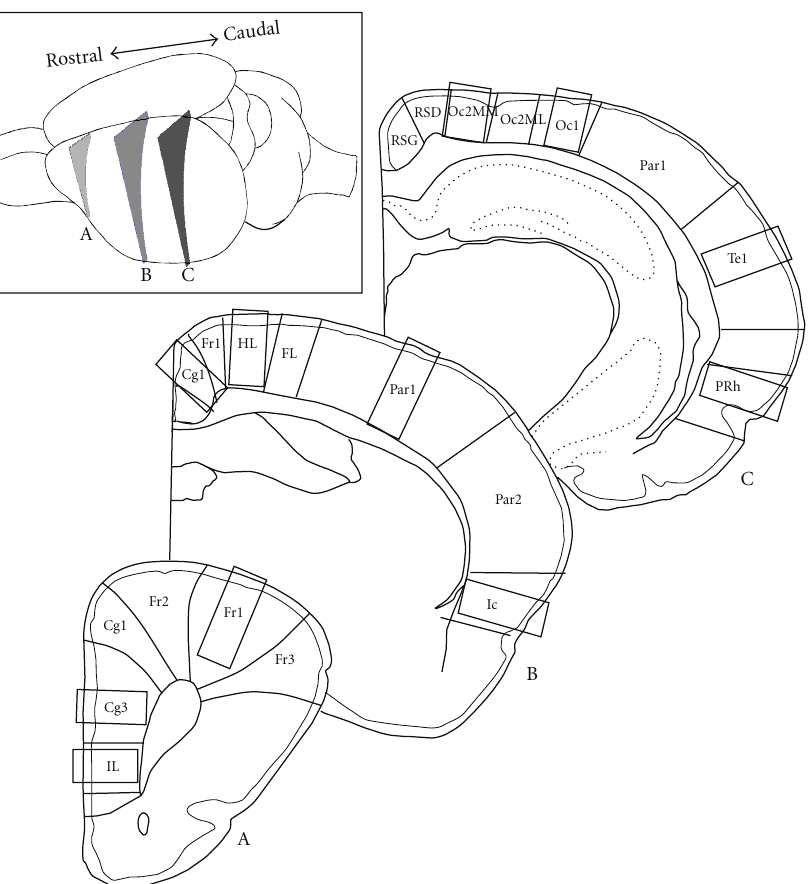
Figure 1: Schematic drawing of the selected cortical areas in which the amount of lysosomal accumulations (LAs) were quantitatively measured. Three coronal sections of the left hemisphere were chosen (left upper corner) including at Bregma +3.2mm (A) the cingulate cortex area 3 (Cg3), the frontal cortex area 1 (Fr1), and the infralimbic cortex (IL); at Bregma-1.3 mm (B) the cingulate cortex area 1 (Cg1), the hindl i mb area (HL), the parietal cortex area 1 (Par1), and the insular cortex (IC); and at Bregma − 4.3 mm (C) the occipital cortex area 1 (Oc1) and area 2 mediomedial (Oc2MM), the temporal cortex area 1 (Te1), and the perirhinal cortex (PRh). Rectangles indicate the respective measuring fields.